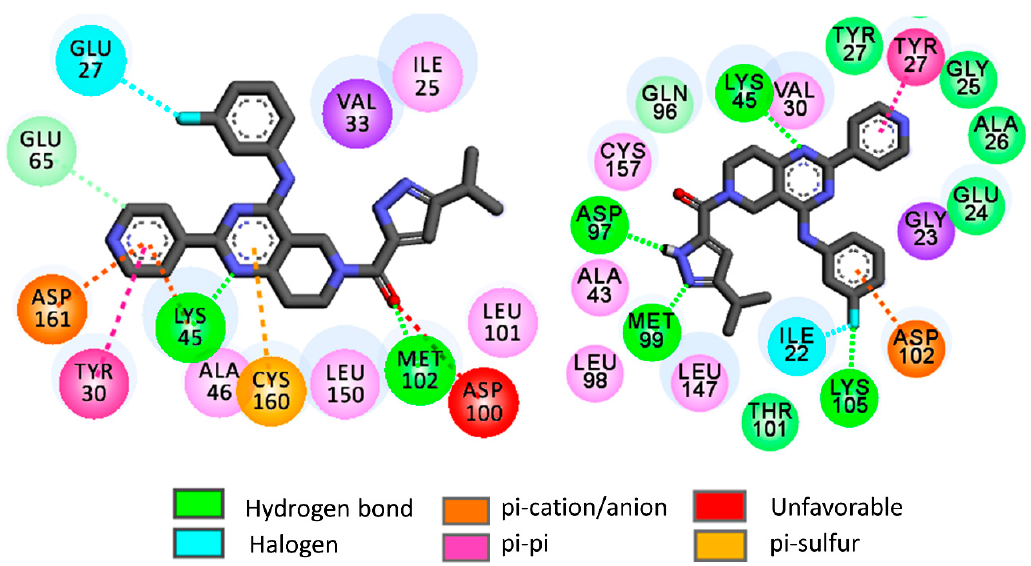
Figure 8. 2D flexible docking interaction diagrams of H1 with ERK-1 or 4QTB ( left ) and ERK-2 or 4QTA ( right ).